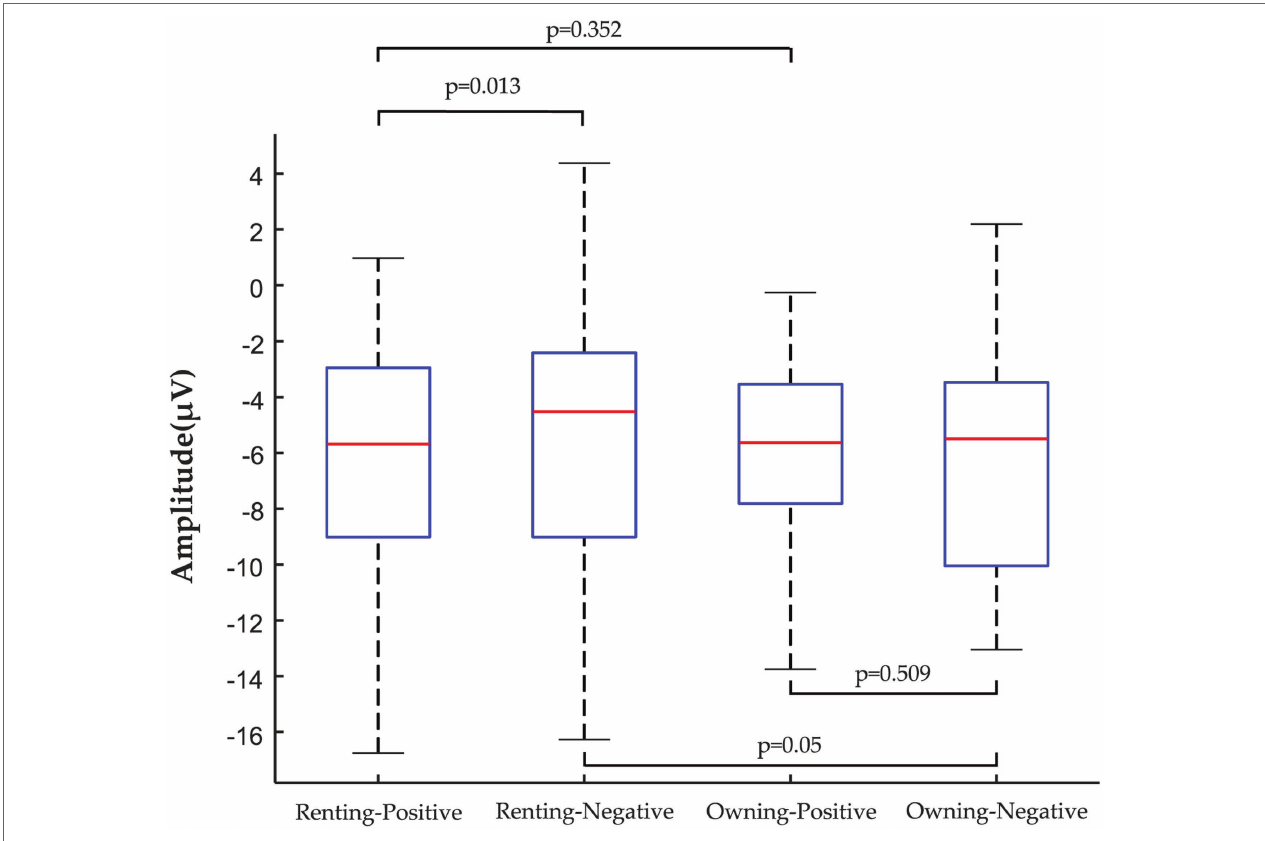
FIGURE 4 | ANOVA of peak amplitude data: the comparison between the housing tenure choice and